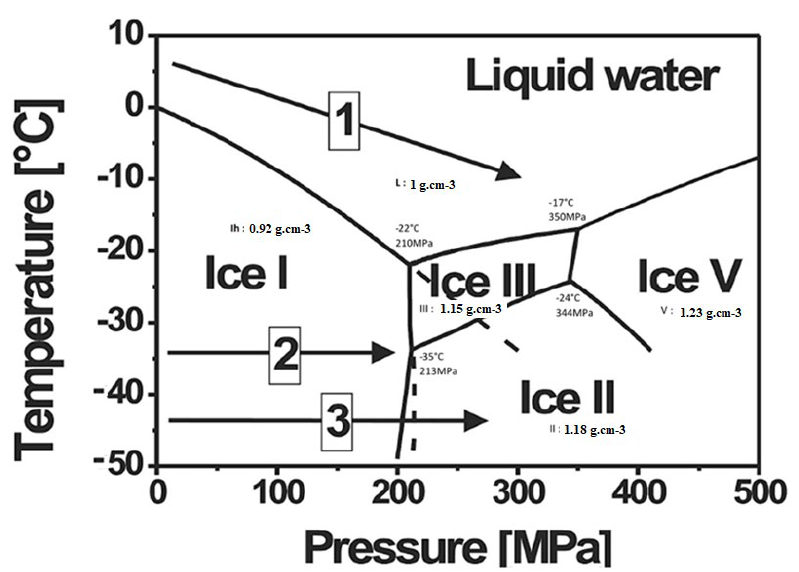
Figure 1. P-T diagram of water and their corresponding densities [78].